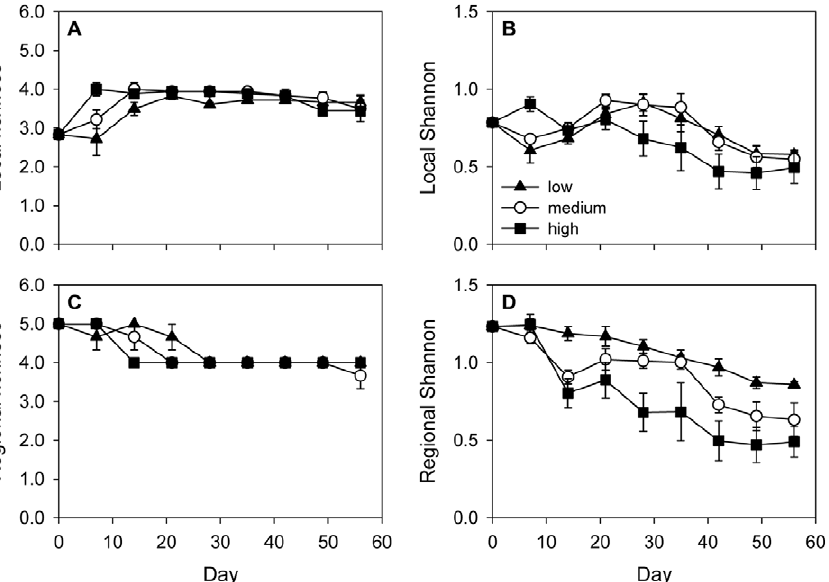
Figure 2. Local and regional diversity with low, medium, and high connectivity. The measures of diversity used were species richness (A, C) and the Shannon-Wiener index (B, D), computed at the local (A, B) and regional scale (C, D), respectively. Values are means 6 SE, n=3.